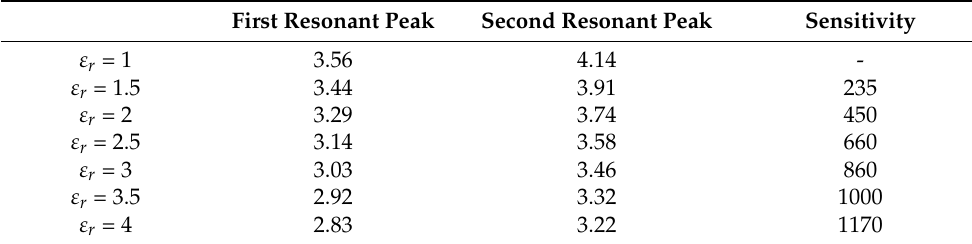
Table 4. Sensitivity performance for different dielectric constants.